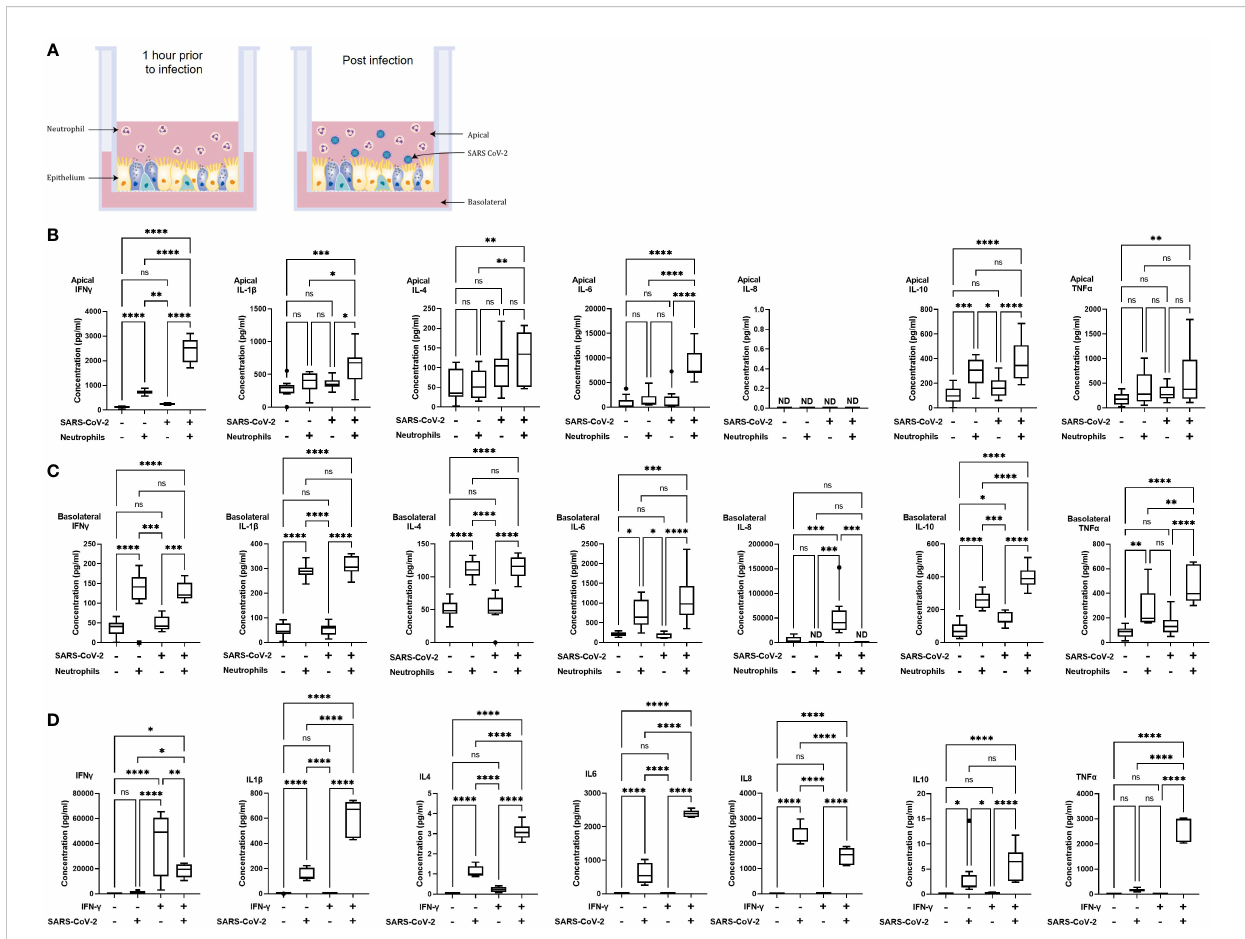
FIGURE 1 Polarized in fl ammatory response of neutrophils in co-culture with human airway epithelium, infected with SARS-CoV-2. (A) Schematic of the in vitro model of neutrophilic airways denoting neutrophils in co-culture with differentiated airway epithelial cells and infected with live SARS-CoV-2 virus. In fl ammatory pro fi les of apical (B) and basolateral (C) supernatants collected 4 hours post infection in the neutrophilic airway model. (D) In fl ammatory pro fi le of naïve or IFN- g (50ng/ml 1 hour) neutrophil monocultures infected with SARS-CoV-2 virus for 4 hours. Data is expressed as Tukey method box & whiskers plots. Signi fi cance is determined by analysis of variance (ANOVA) followed by Tukey ’ s post hoc analysis. *p<0.05,**p<0.01, ***p<0.001, ****, <0.0001 from n=3 experimental repeats from N=3 donors. ns, not signi fi cant, ND, not done as an